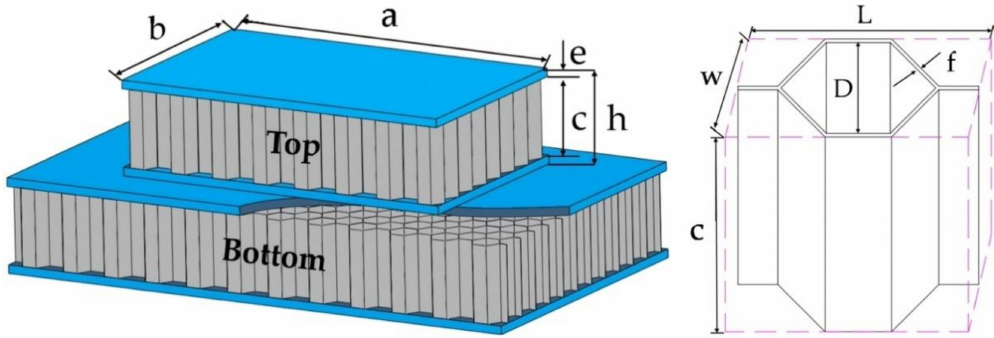
Figure 1. Structure of honeycomb sandwich.